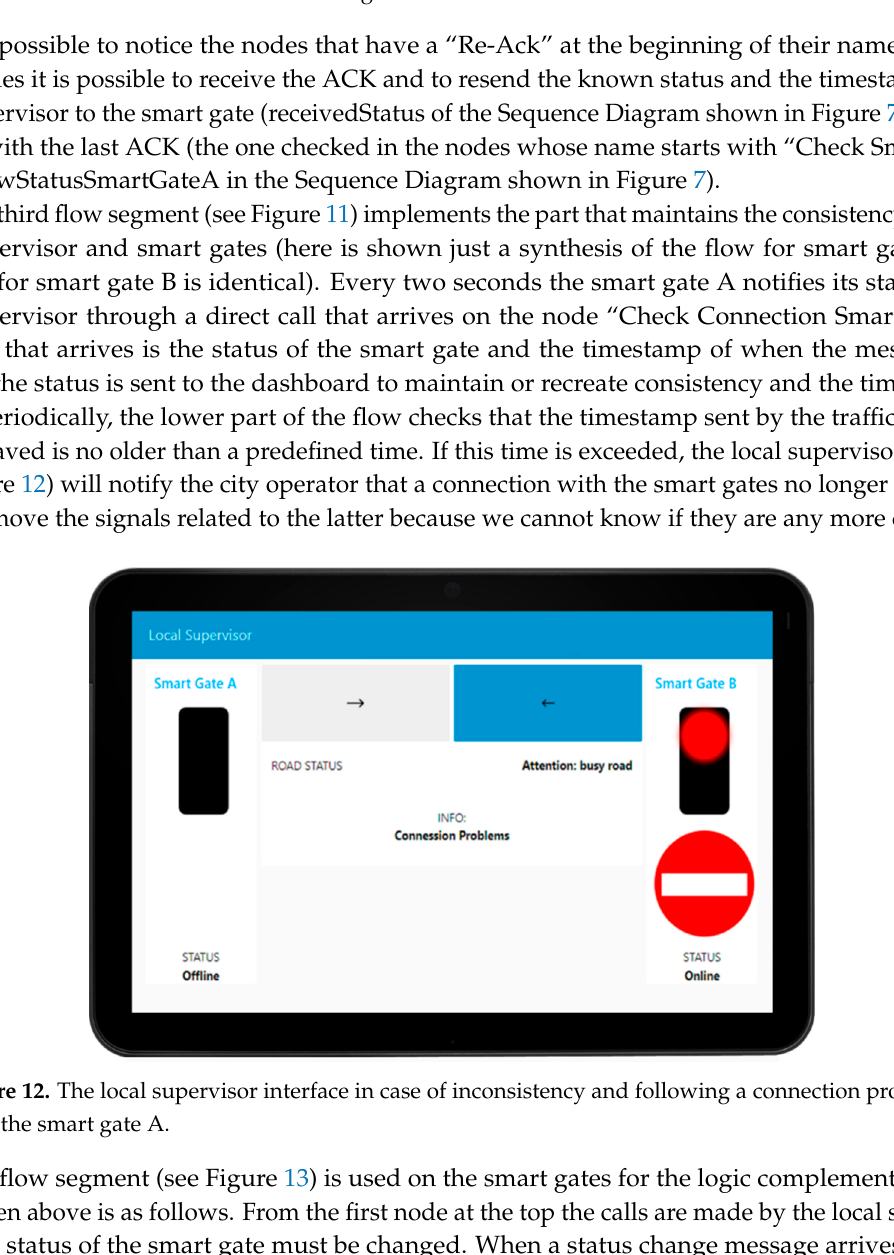
Figure 13. Flow that realizes the logic of the smart gate. The upper part is the one that receives the status and changes it if the ACK exchange is successful. The lower part is the one that checks if the connection is always active between the local supervisor and the smart gate.